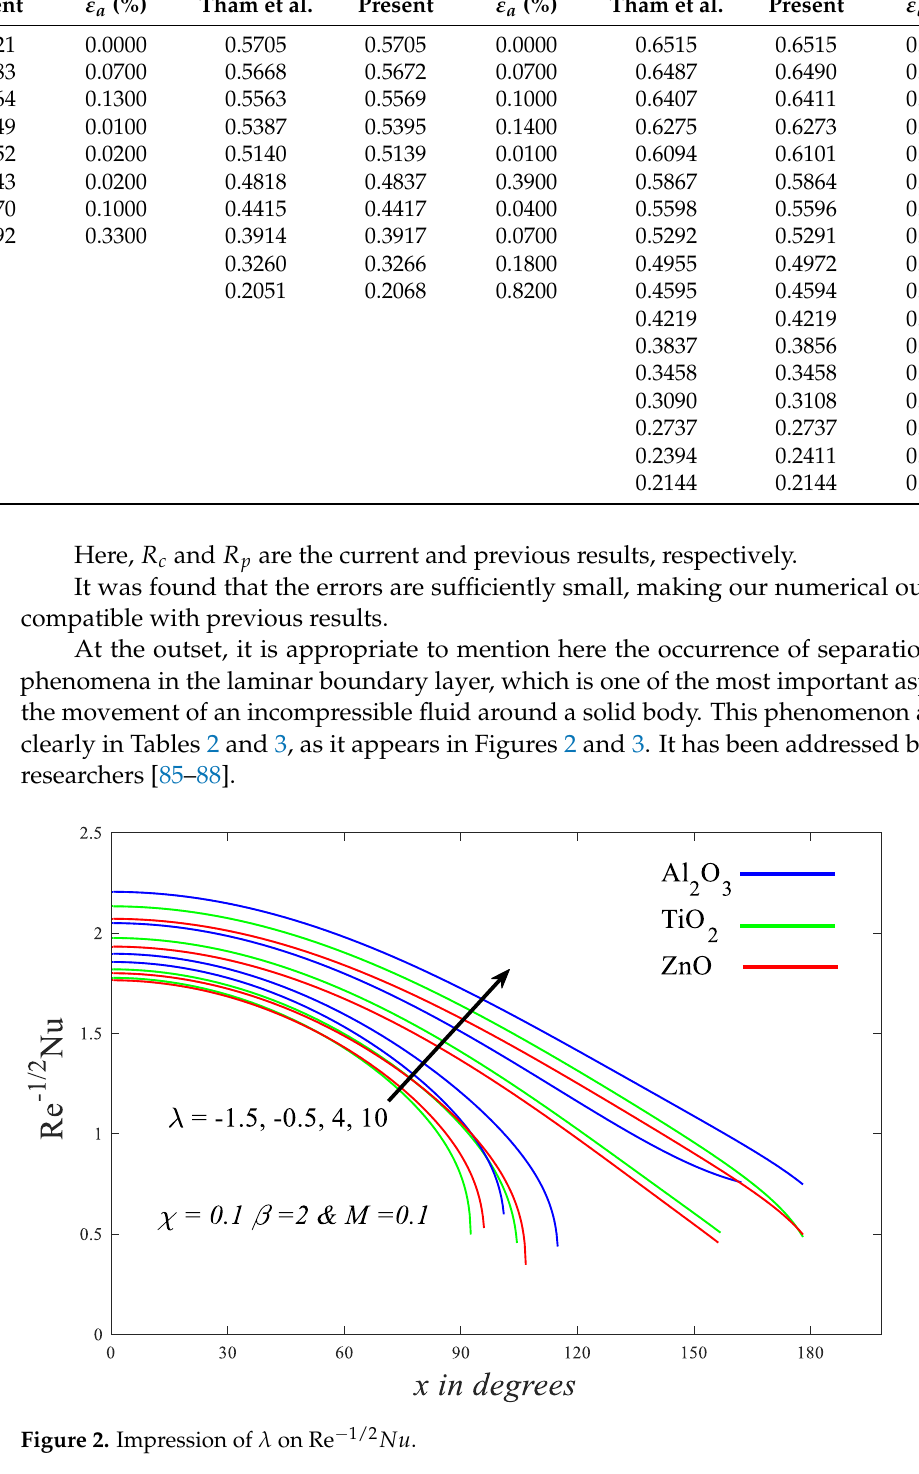
Figure 3. Impression of  on 1/2 Re f C . Figures 2 and 3 depict the impression of the combined convection parameter on the Nusselt number and skin friction in both flow states ( 0& 0    ) with volume fraction fixed at 0.1  , Casson parameter at 2   , and magnetic parameter 0.1  M . It can be observed from Figure 2 that an ascending trend of the mixed convection parameter is accompanied by a rising Nusselt number. This occurs due to the enhancement of the buoy- ancy forces, which are produced by the increasing combined convection parameter. Ac- cording to Figure 3, as the values of the combined convection parameter grow, the skin friction follows the same tendency as the Nusselt number. This is due to an increase in buoyancy forces too.